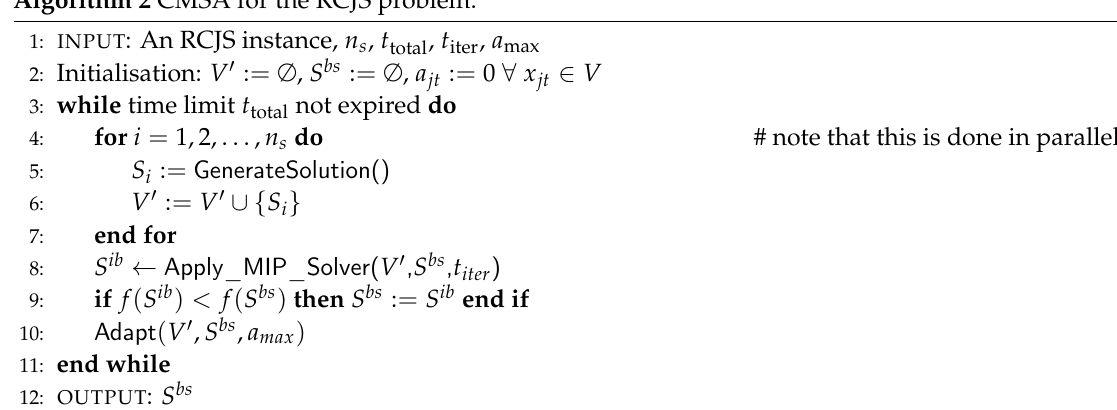
Algorithm 2 CMSA for the RCJS